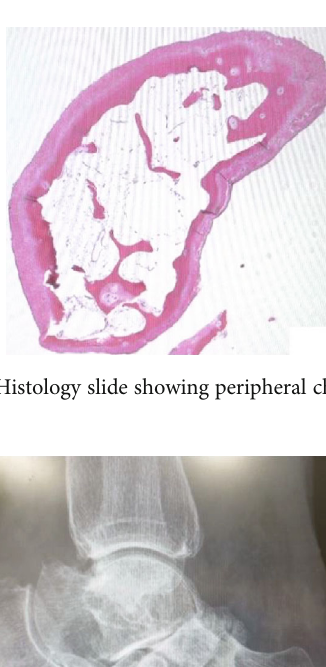
Figure 6: Photograph showing the loose bodies that were endoscopically removed from the right posterior ankle extra-articular space.